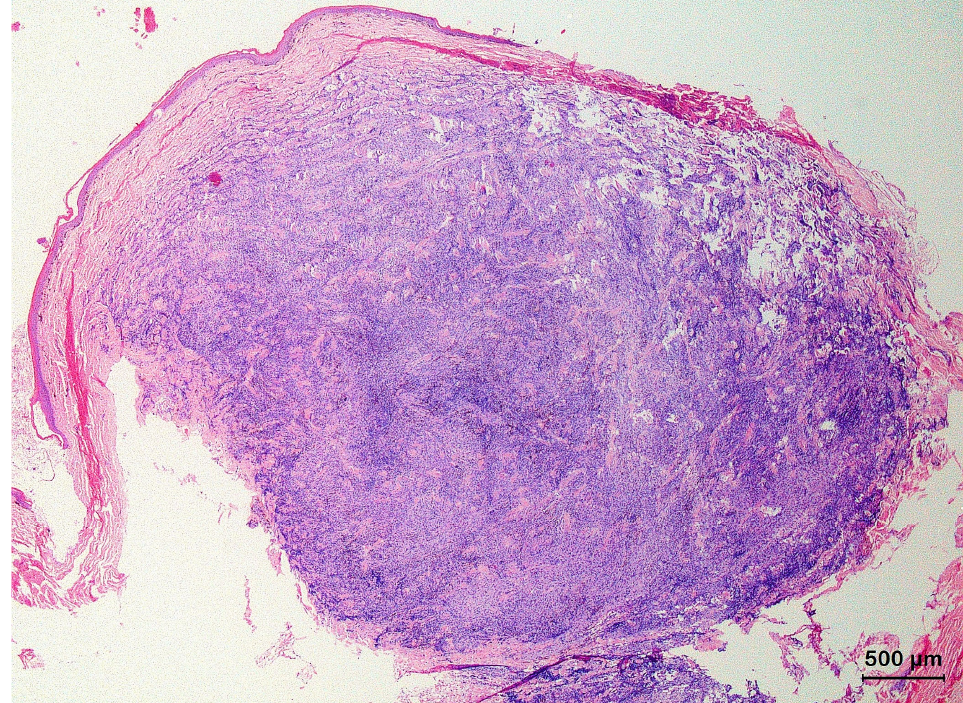
Figure 5. Histological section of a solid basal cell carcinoma originating from the skin of the front leg of a red-eared slider ( Trachemys scripta elegans ) characterized by a nodular pattern composed of cords of small polyhedral basaloid cells extending into the dermis.